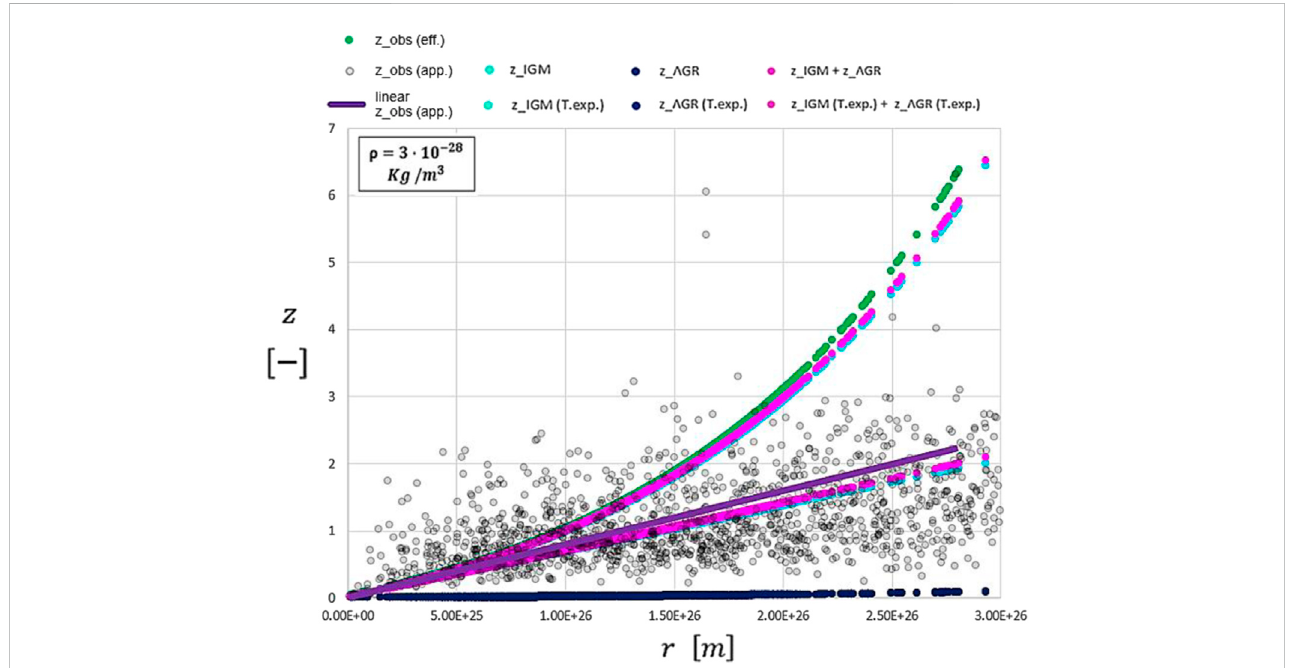
FIGURE 13 Comparisonbetweenapparentquasarredshifts(graydots)witheffectivequasarredshifts(greendots)basedontheeffectivedistancesanditslineartrend (violet line). All other contributions are represented by the fuchsia, sky-blue, and blue exponential curves and by their Taylor expansions (fuchsia, sky-blue, and blue lines) reported as “ T.exp. ” The blue line overlaps with the blue curve.